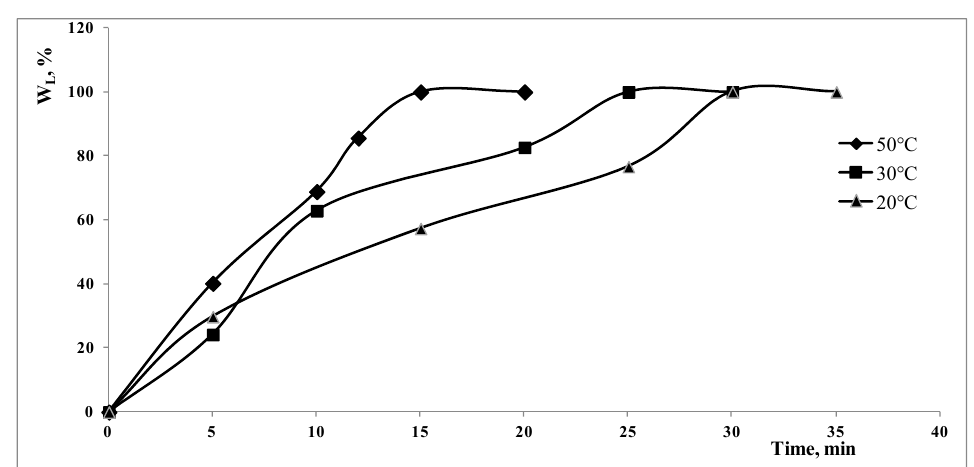
Figure 2. Percentage weight loss during the ultrasonic treatment at the ammonia concentration of 0.75%, maximum power of the ultrasonic bath and at three different temperatures.